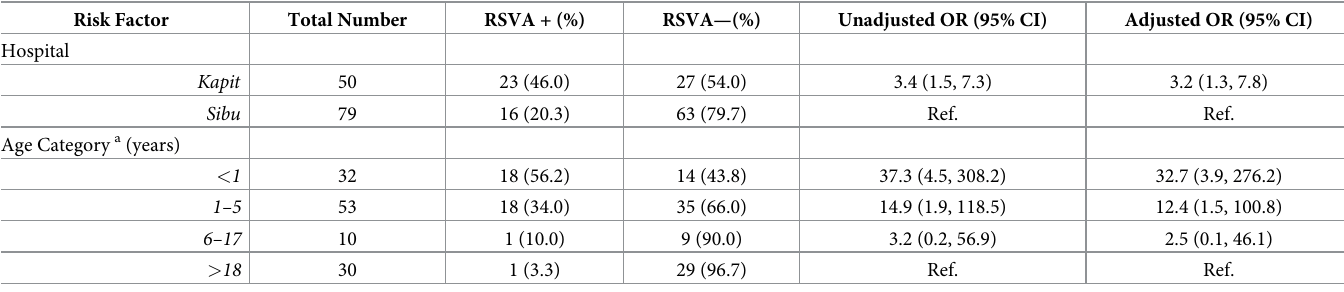
Table 1. Significant risk factors for molecular detection of